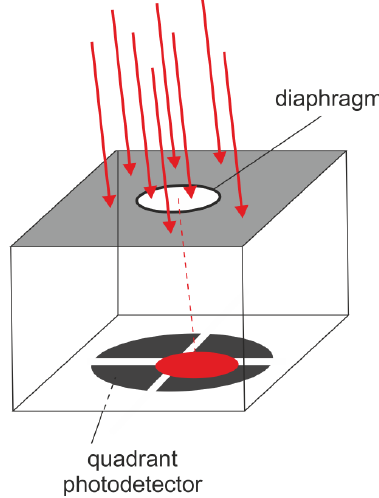
Figure 2. Idea of an LWR based on a quadrant photodetector.